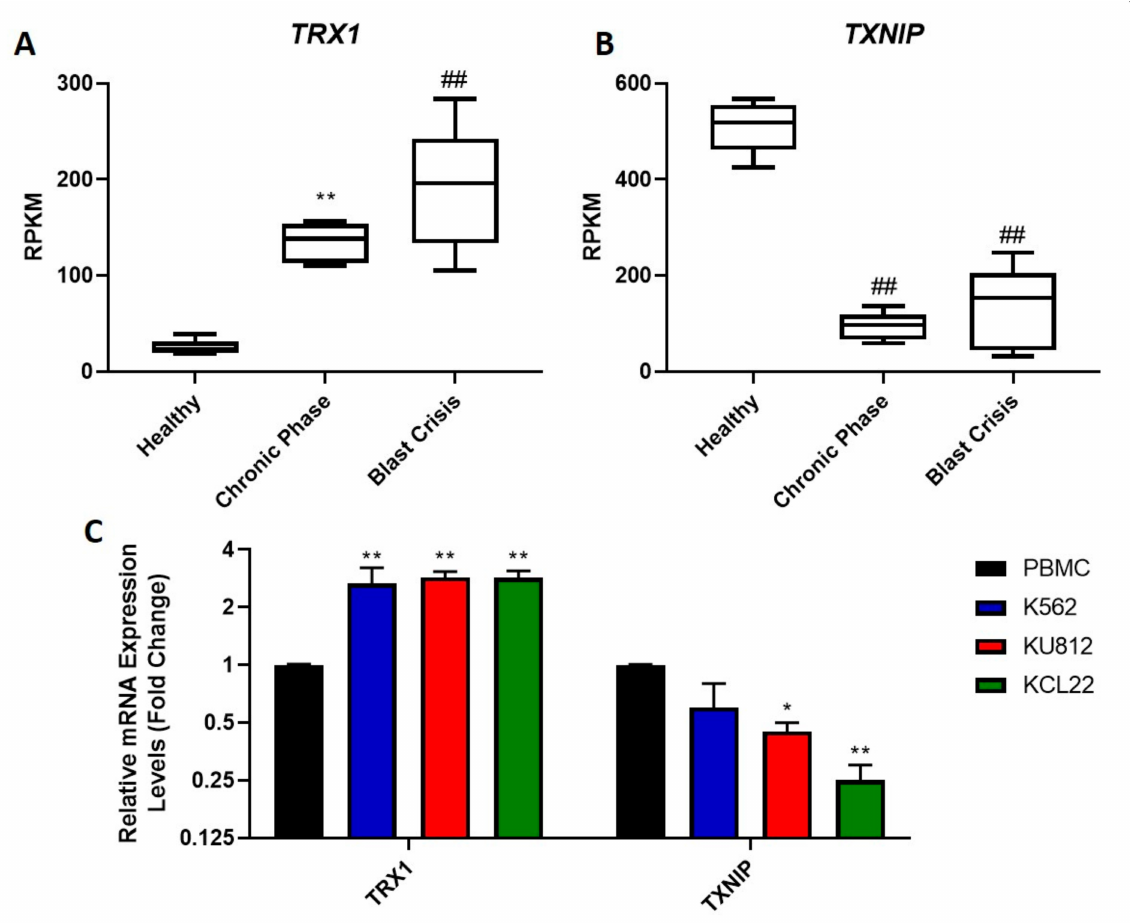
Figure 1. The mRNA expression of the TRX system in cancerous and non-cancerous cells. RNAseq data from the GSE100026 database were used to measure expression levels of TRX1 ( A ) and TXNIP ( B ) in healthy, chronic phase and blast crisis patients. Gene expression is displayed as reads per kilobase of transcript per million mapped reads (RPKM). One-way ANOVAs were used to compare results between CML patients and healthy donors. Results are displayed as RPKM, N = 5. The mRNA expression levels of TRX1 and TXNIP were measured in PBMCs and in K562, KU812 and KCL22 CML cells using RT-qPCR ( C ). RPL32 was used to normalize mRNA levels. One-way ANOVAs with a Dunnett’s post hoc test were used to compare expression of each gene in the PBMCs to that of each of the three CML cell lines, N = 3. Values displayed as mean ± SEM. Significant results are denoted with an * (* = p < 0.05, ** = p < 0.01, ## = p <